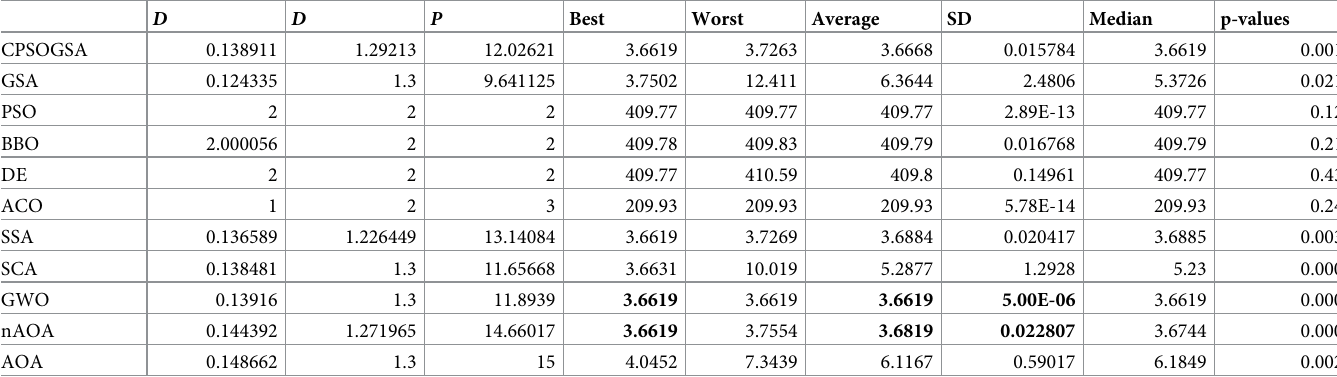
Table 7. Results for experiment conducted for